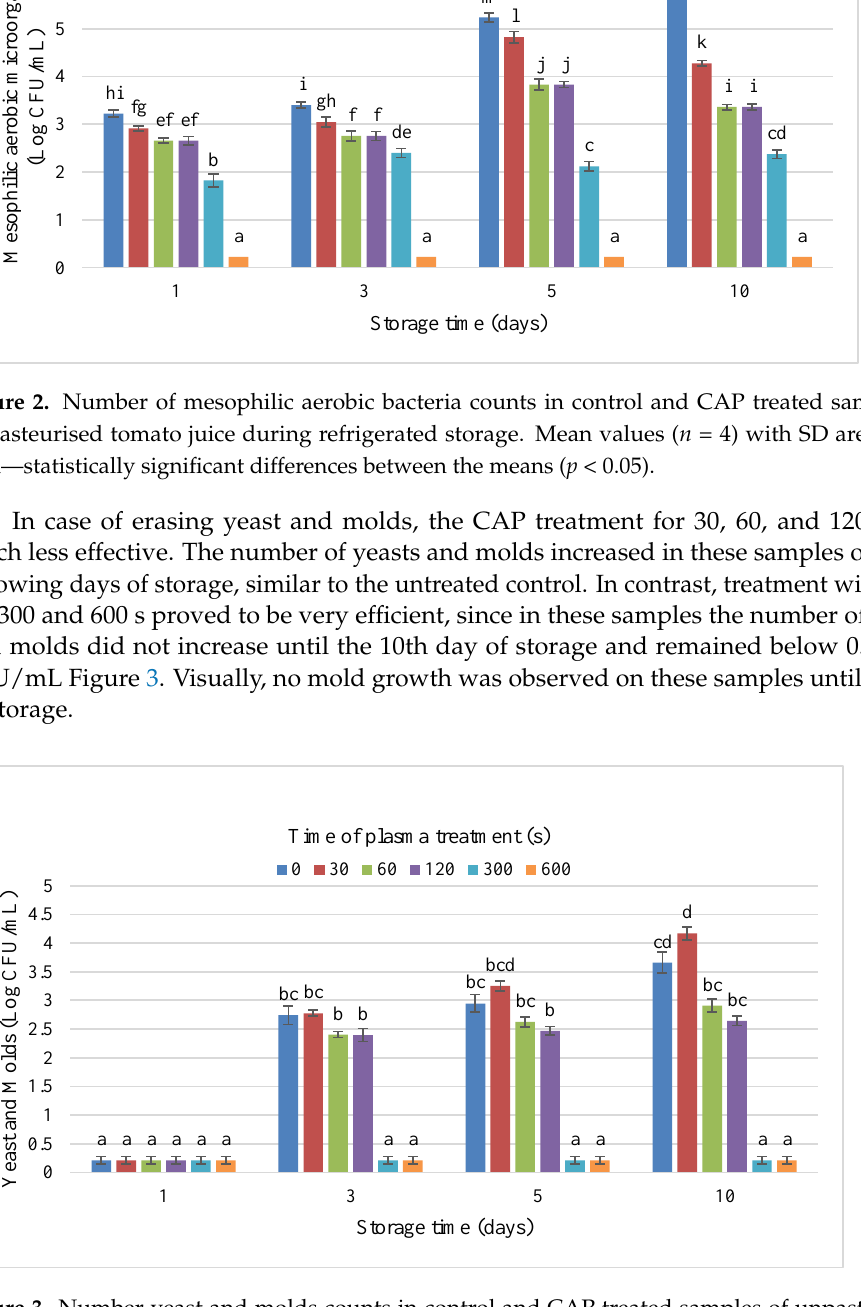
Figure 3. Number yeast and molds counts in control and CAP treated samples of unpasteurized tomato juice during refrigerated storage. Mean values ( n = 4) with SD are shown. a, b, c — statistically significant differences between the means ( p < 0.05).